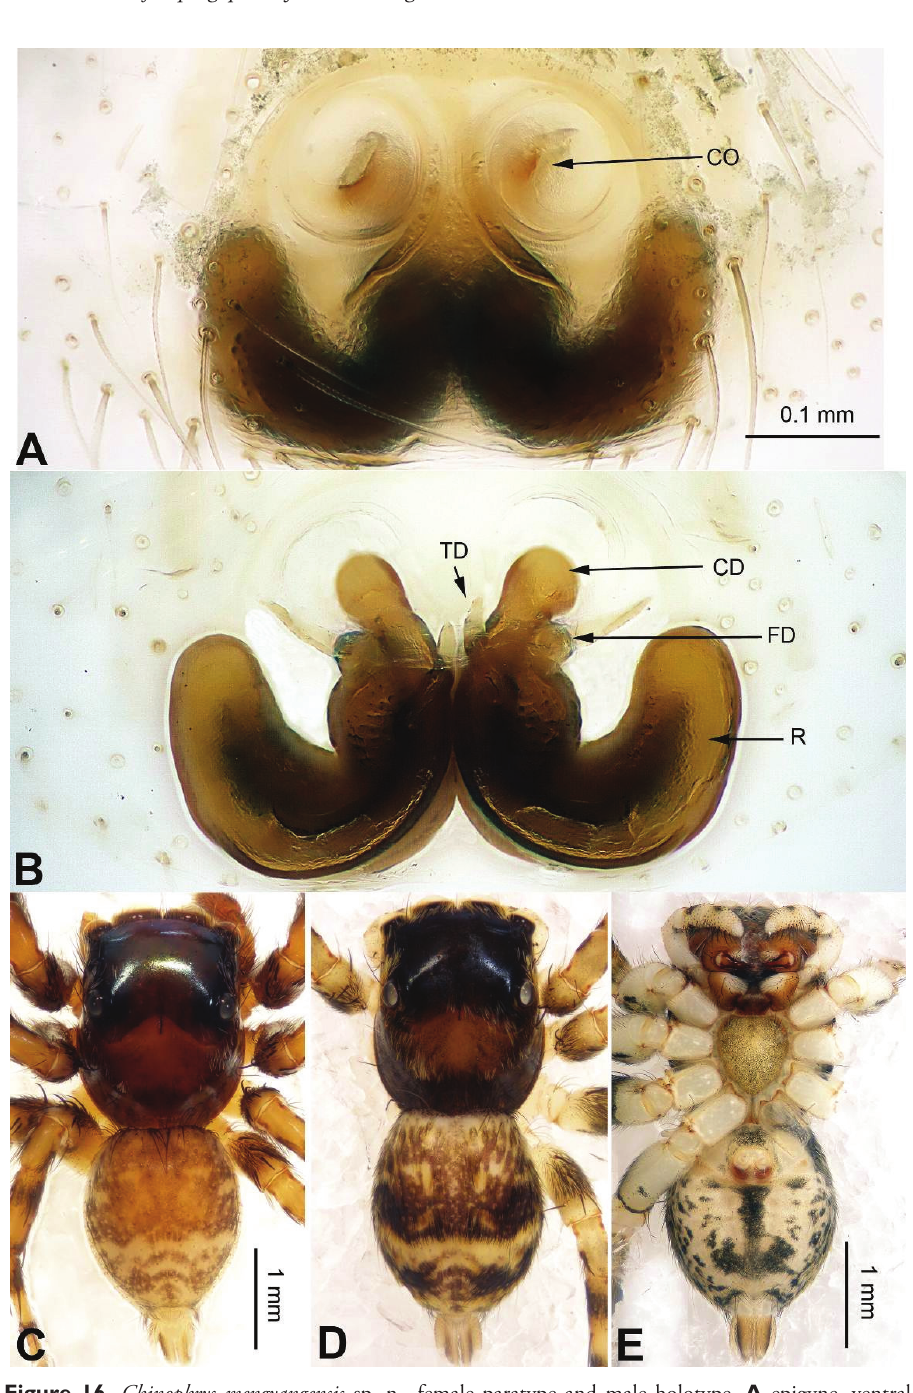
Figure 16. Chinophrys mengyangensis sp. n., female paratype and male holotype. A epigyne, ventral B vulva, dorsal C male habitus, dorsal D female habitus, dorsal E female habitus, ventral. Scale bars equal for A and B ; equal for D and E